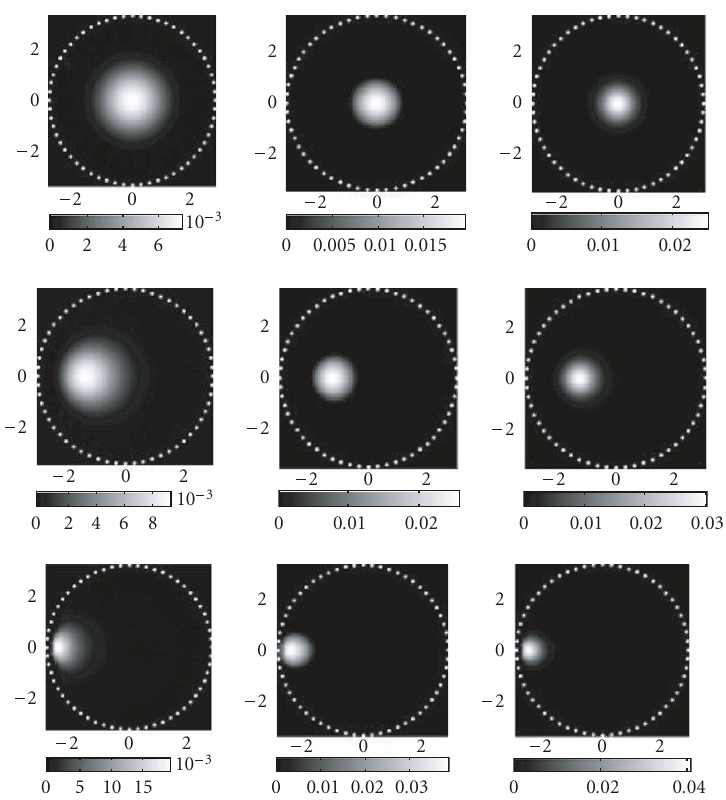
Figure 5: The best results of restoration by unpreconditioned algorithms in comparison with the results of blurred image reconstruction: the first set of phantoms.